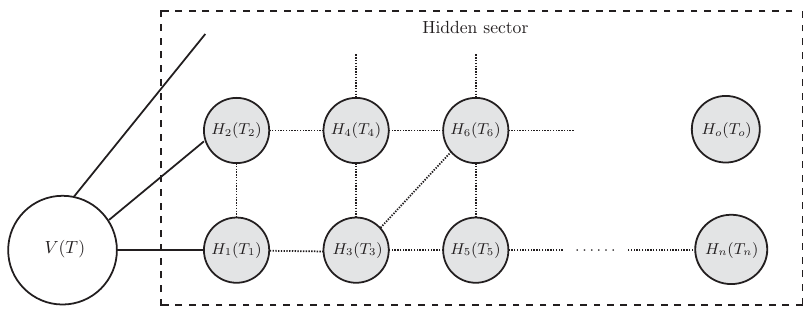
Figure 2 . A schematic diagram exhibiting the coupling of the visible sector with multiple dark sectors and of the dark sectors among themselves. The visible sector may have direct couplings with some of the dark sectors, or indirect couplings with others via interactions among the entire hidden